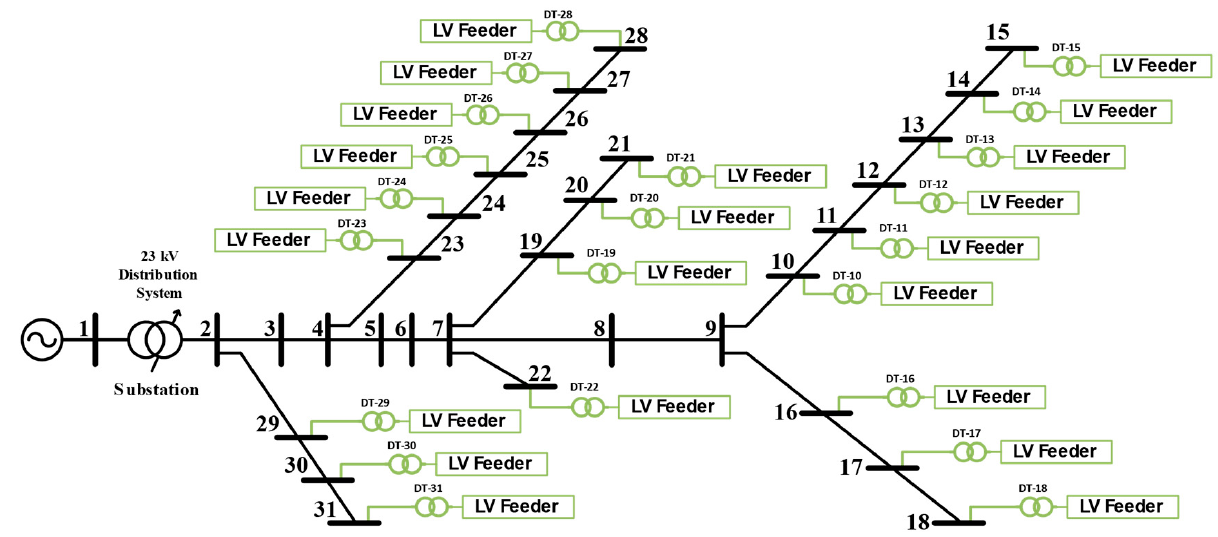
Figure 3. The 449-node radial test system comprising of IEEE-31 bus system and 22 LV residential feeders, developed from ref [25]. For the daily residential load curve, real values (Western Australia) from a distribu- tion transformer are used, as shown in Figure 4. The average peak demand of each house is 2 kW with a power factor of 0.9. ToU tariff scheme is used, and all the nodes are at different distances from the distribution transformer, so the line data vary according to their length. A 10 MVA, 132 kV/23 kV substation transformer is connected between nodes 1 and 2, and there are 22 distribution transformers (DT-10 to DT-31) to facilitate the household loads.